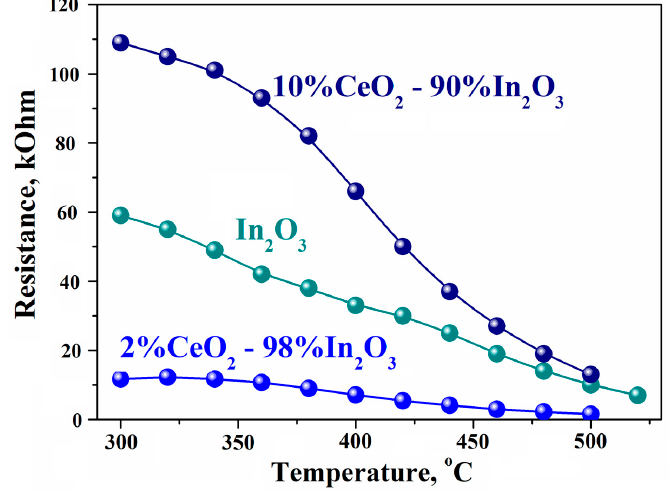
Figure 6. Temperature dependences of the resistance of In 2 O 3 and CeO 2 –In 2 O 3 composites.